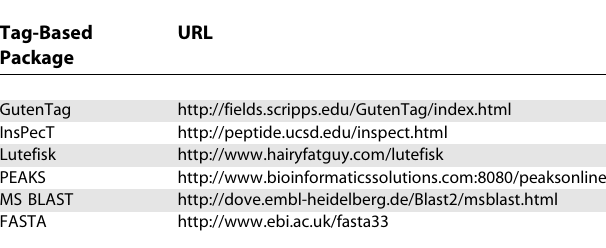
Table 3. Popular Packages for De Novo Sequencing of MS Data and Tag-Based Protein Identification